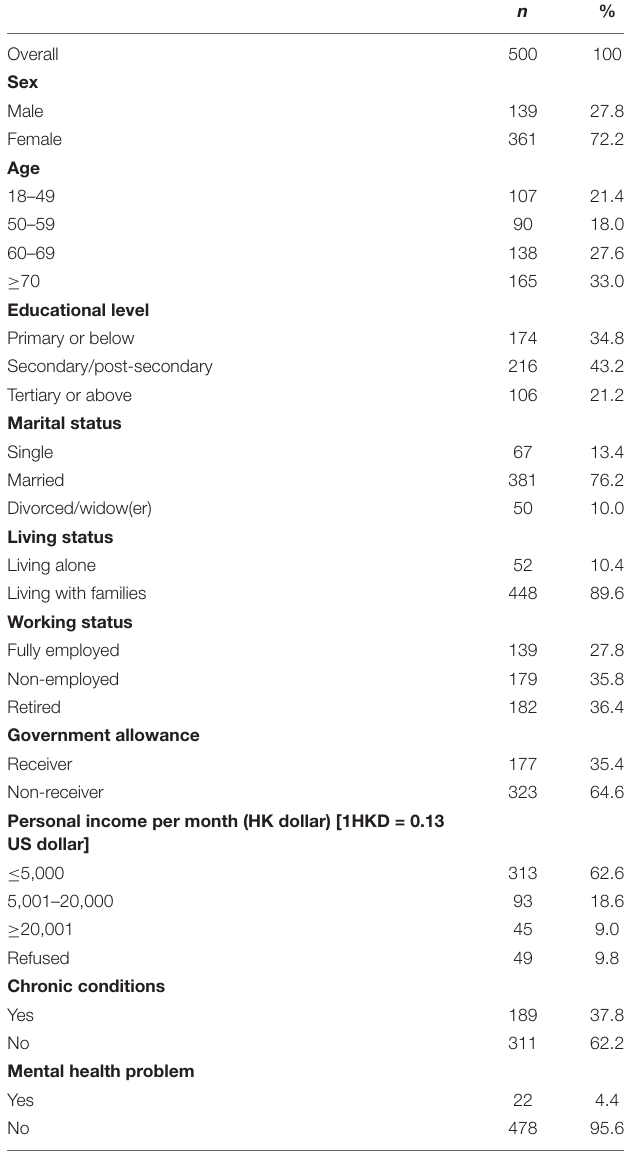
TABLE 1 | Participants’